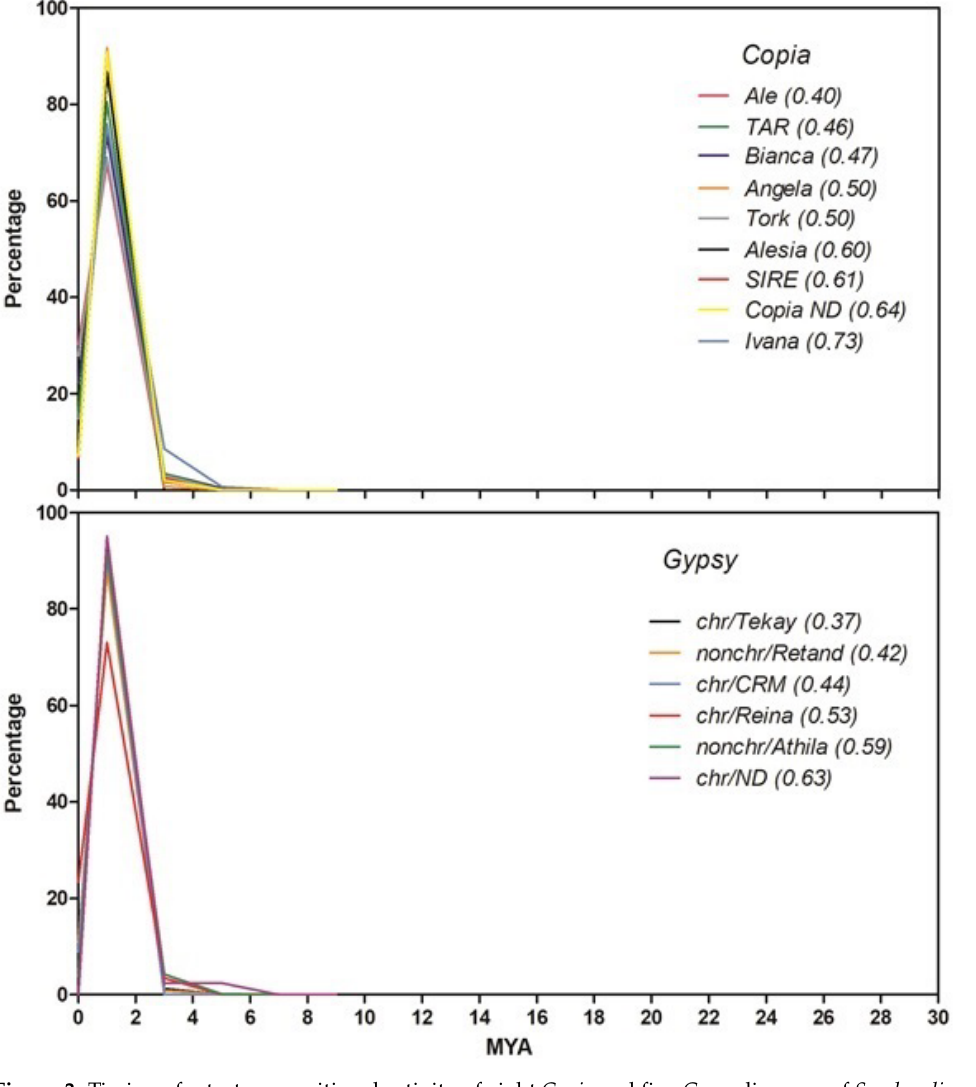
Figure 3. Timing of retrotranspositional activity of eight Copia and five Gypsy lineages of S. rebaudiana based on pairwise comparisons of the LTRs of each full-length element. For each lineage, the average insertion time (in MYA) is reported in parentheses. MYA, million years ago; chr, Chromovirus; nonchr, non-Chromovirus; ND, not determined.